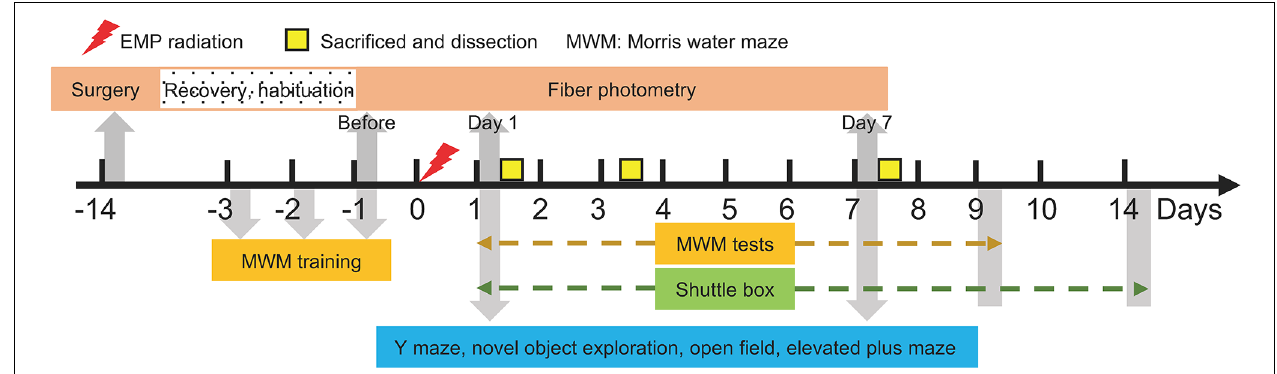
FIGURE 1 | Temporal design of the